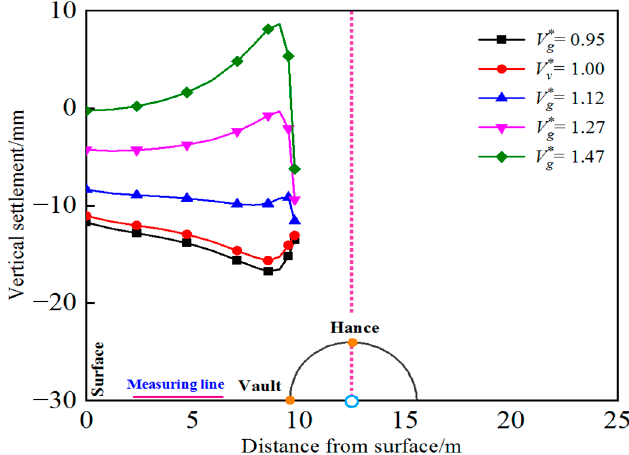
Figure 24. Vertical deformation of the stratum under different synchronous grouting ratios V ∗ g